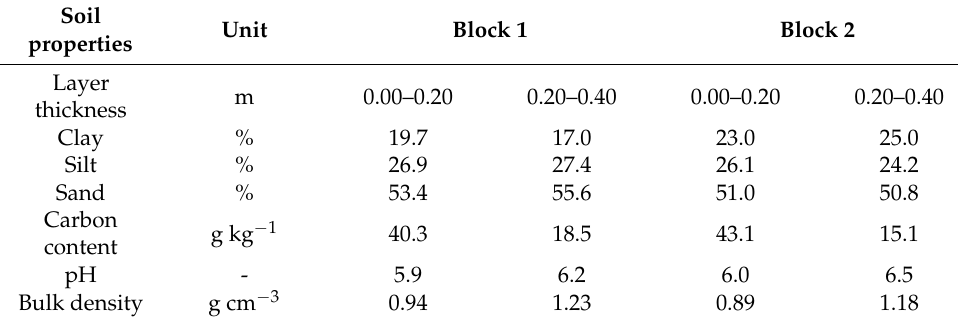
Table 1. Soil properties of the grassland study-site (mean of the six plots per